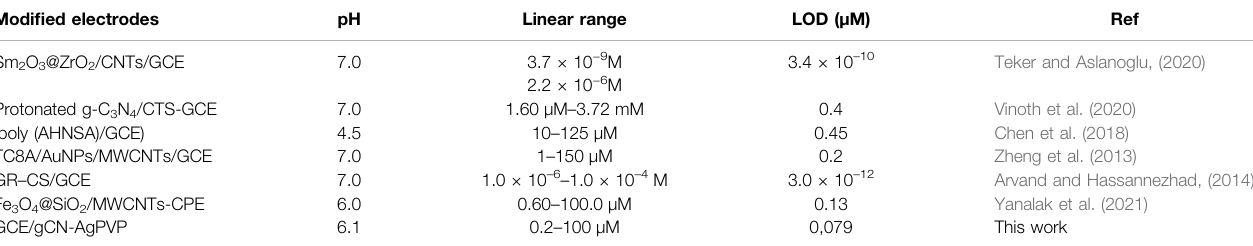
TABLE 1 | Comparison of GCE-gCN-AgPVP to another electrode modifying composite. Modi fi ed electrodes